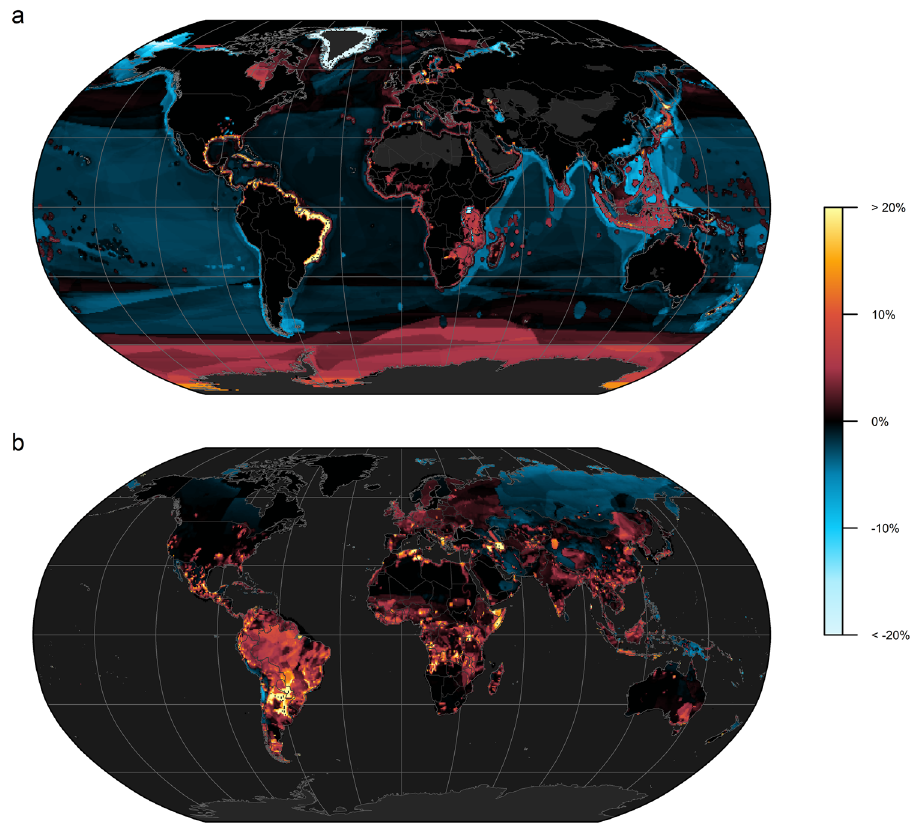
Fig. 3 Data De fi cient species change conservation priorities. Percent change in average PE score (i.e., predicted probability of being threatened by extinction) for marine ( a ) and non-marine species ( b ) following the inclusion of Data De fi cient species alongside data-suf fi cient